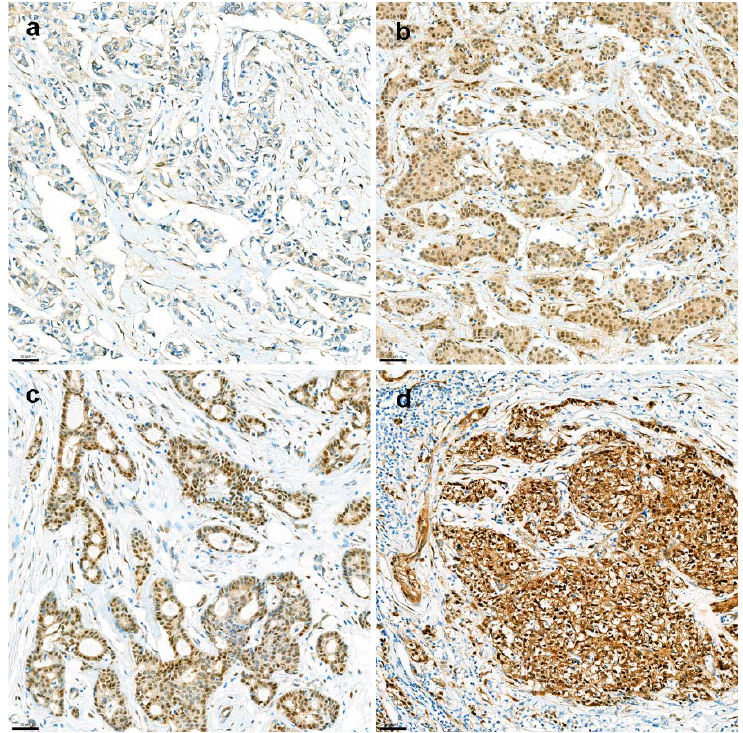
Figure 3. Immunohistochemistry for nuclear YAP1 expression. Nuclear YAP1 expression was evaluated in high-power fields (400× magnification) by two breast cancer pathologists. Expression intensity was graded as negative ( a ), weak ( b ), moderate ( c ), or strong ( d ).